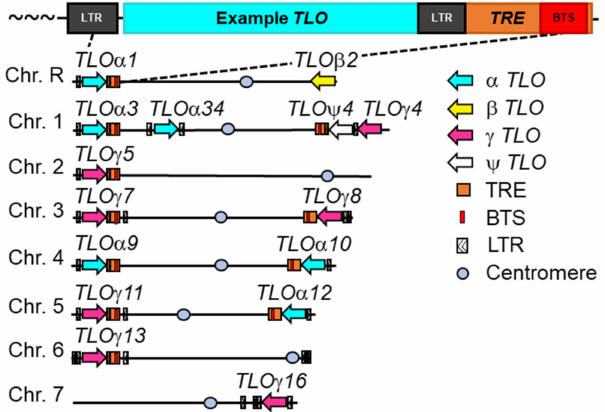
Figure 2. Organization of subtelomeric repetitive sequences in C. albicans . The telomere-associated ( TLO ) genes and other subtelomeric repetitive sequences are marked on each C. albicans chromosome arm for the genome reference strain SC5314. The TLO open reading frame (ORF; cyan) is commonly flanked by two long terminal repeats (LTR) elements, indicated in black. The TLO recombination element (TRE; orange) overlaps with the TLO 3’ untranslated region (UTR) and extends towards the centromere to encompass the Bermuda Triangle Sequence (BTS; red). All repetitive sequences are oriented similarly on all chromosome arms. Both the TRE and BTS contribute to subtelomeric recombination. Telomeric repeats are denoted by “~~~”. Figure adapted from